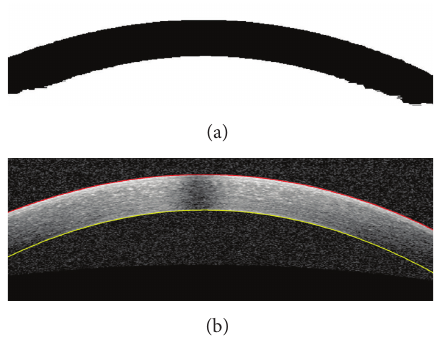
Figure 7: Extrapolation to low SNR regions. (a) The second derivative plot of Endothelium layer boundary to detect low SNR regions of this boundary. (b) Extrapolation result.